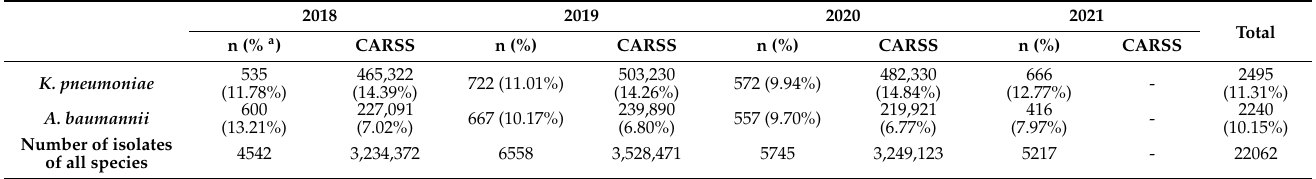
Table 1. Proportions of common pathogenic bacteria in the teaching